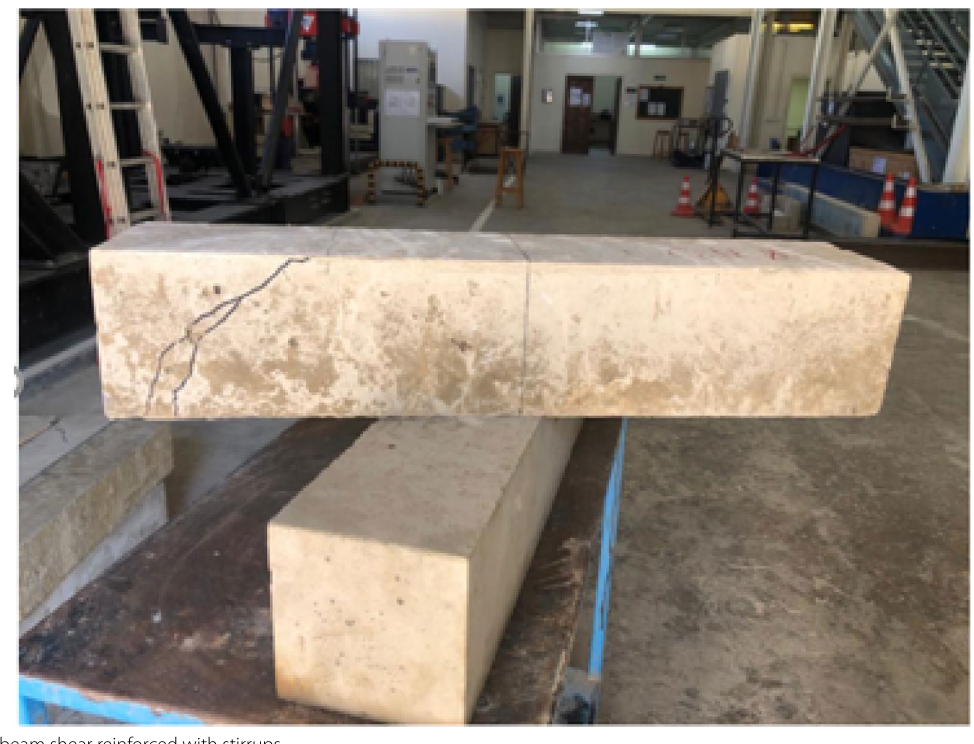
Fig. 11 RC beam shear reinforced with stirrups